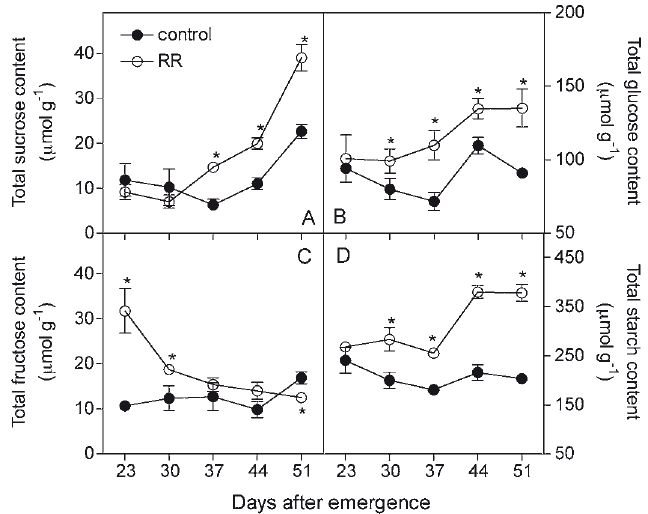
Fig. 5 - Sugar content measured at weekly intervals from day 23 to the end of the experiment in both control and root-restricted (RR) plants:total sucrose (A), total glucose (B), total fructose (C) and total starch (D). * indicates significantly different values for P≤0.05 (n=5), when means were separated by Duncan’s